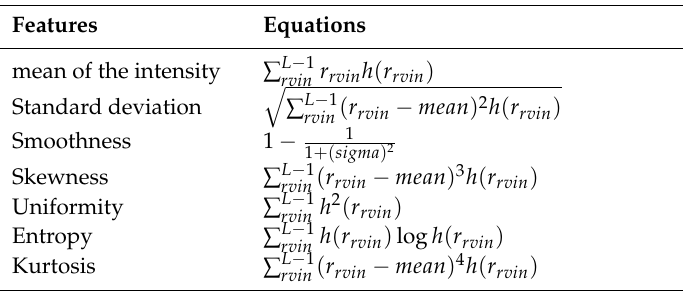
Table 2. Features for